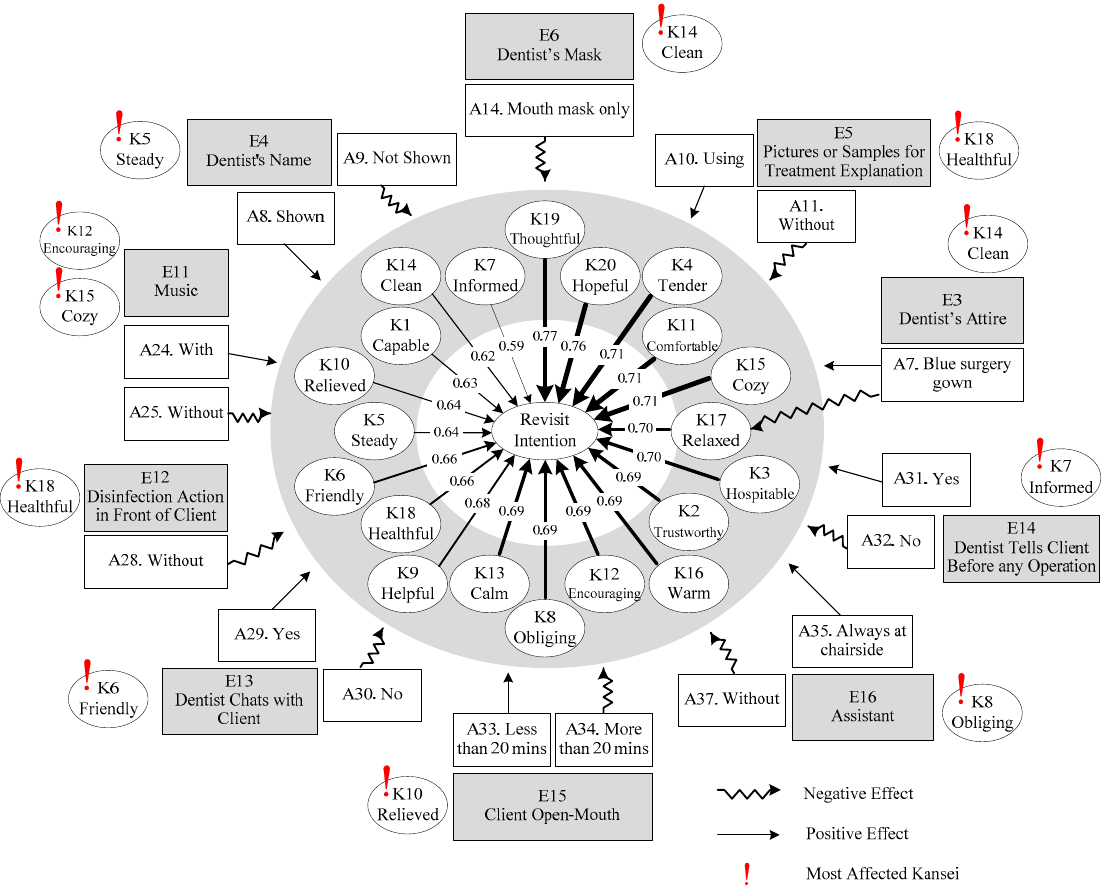
Figure 4. Healthscape element–Kansei–revisit intention relationship plot.